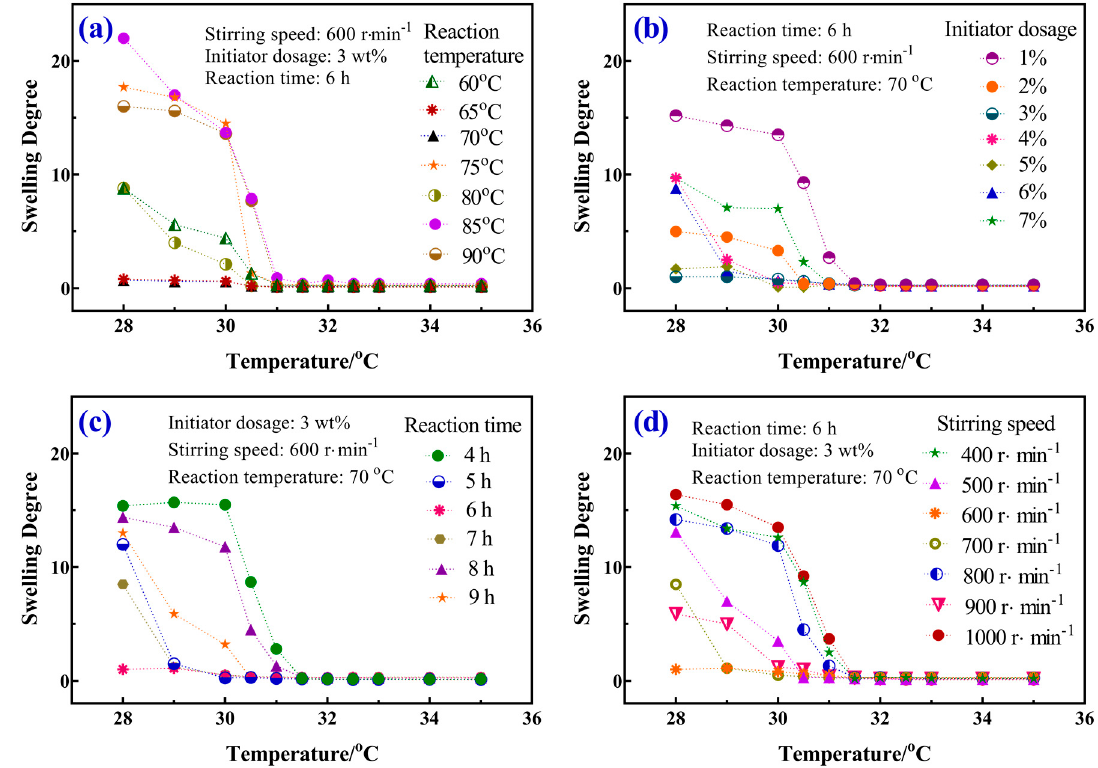
Figure 4. Effect of reaction parameters on the swelling ratio of homogeneous microspheres: ( a ) reaction temperatures, ( b ) initiator dosages, ( c ) reaction time, and ( d ) stirring speed.